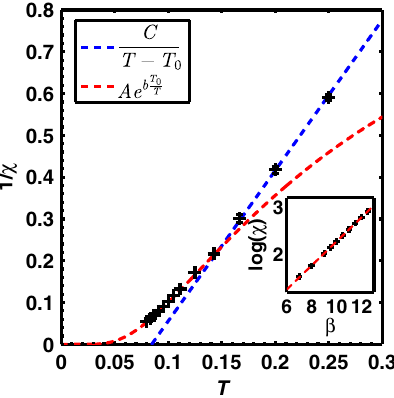
FIG. 6. The SU(2) invariant model in the critical region: χ − 1 ð T Þ at n ¼ 1 , J ¼ 2 , and V ¼ 0 . It crosses over from the CW law to the exponential form of χ ð T Þ ¼ Ae b ð T 0 =T Þ . The inset shows the linear scaling of ln χ ð T Þ versus β .